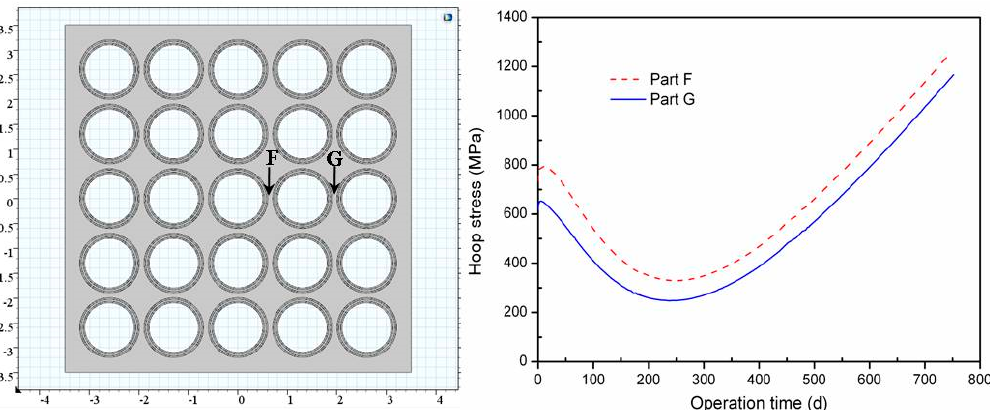
Figure 9. Variation of hoop stress of the inner SiC matrix located between two TRISO particles.